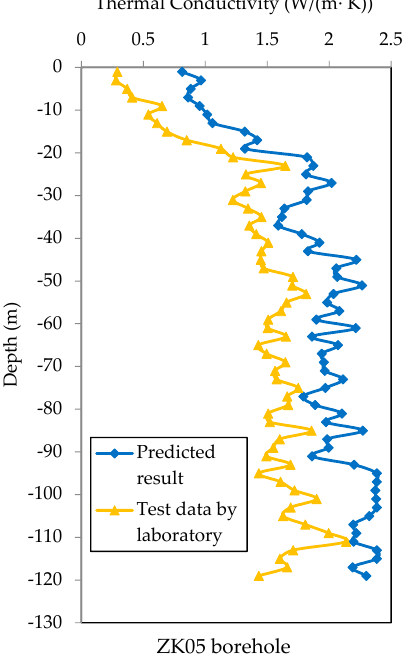
Figure 17. Prediction results of layered thermal conductivity for ZK05.